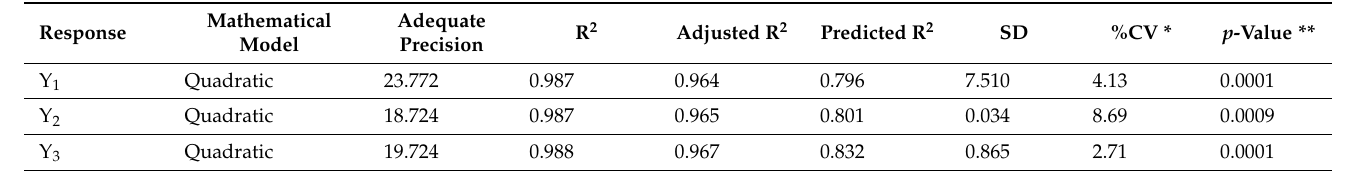
Table 3. Regression analysis for particle size (responses Y 1 ), polydispersity index (Y 2 ), zeta potential (Y 3 ) of tadalafil-loaded niosomes.